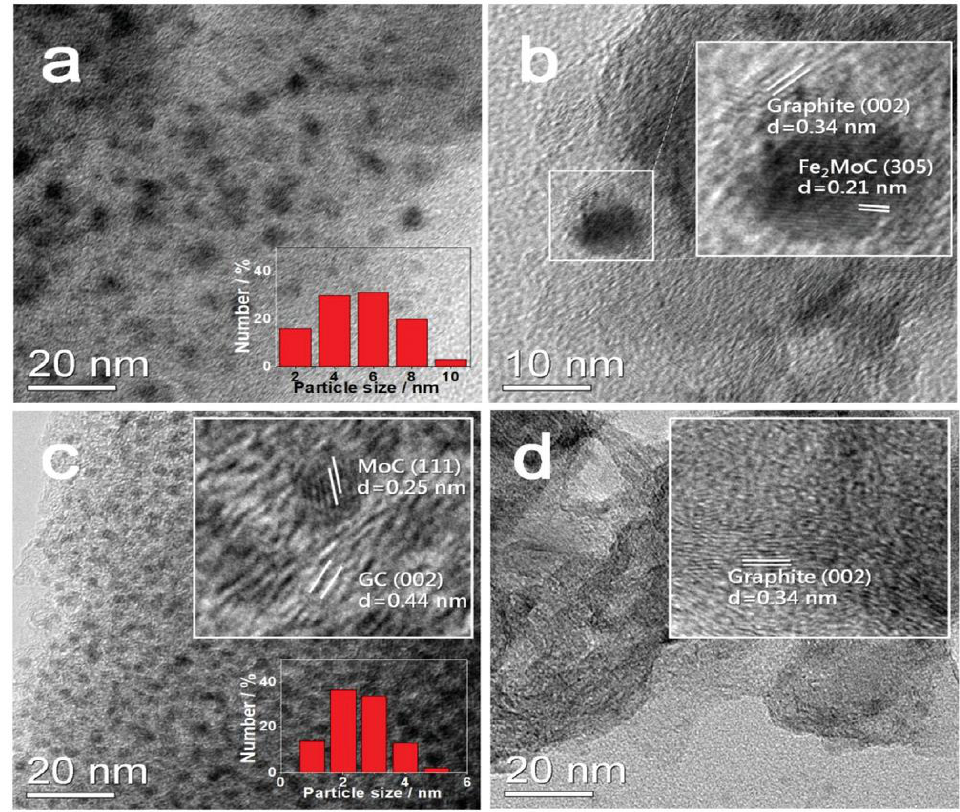
Figure 9. ( a ) TEM image of the prepared catalyst; ( b ) enlarged TEM image of the prepared catalyst; ( c ) TEM image of N-MoC-GC; ( d ) TEM image of N-GC. The bottom inset of the figure shows the corresponding Fe 2 MoC and MoC particle size distributions. The insert at the top of the figure is the correspondence HRTEM image, where the crystal lattice is labeled. (Reprinted with permission from [118]. Copyright 2022, John Wiley and Sons).